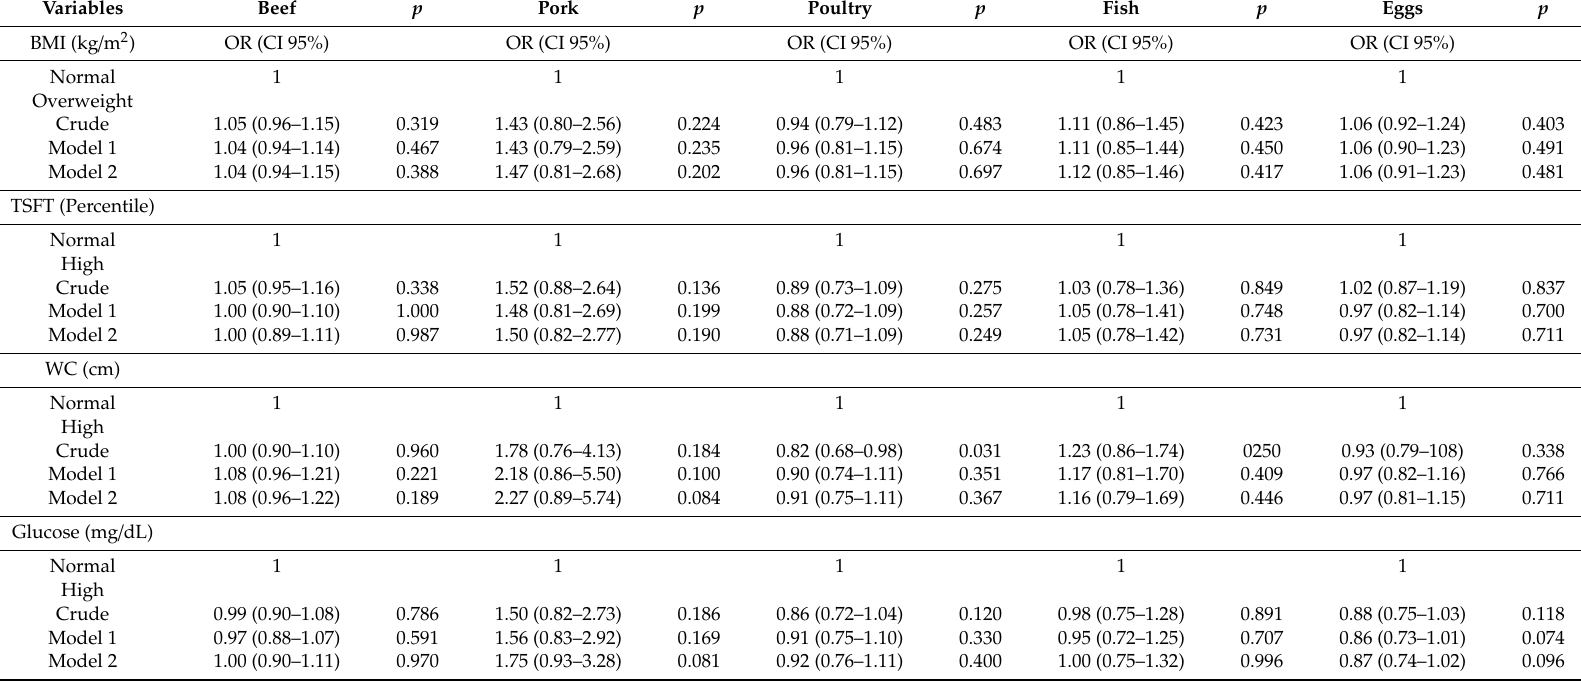
Table 5. Association (Odds ratio) between meat and egg intake with anthropometric measurements and blood glucose